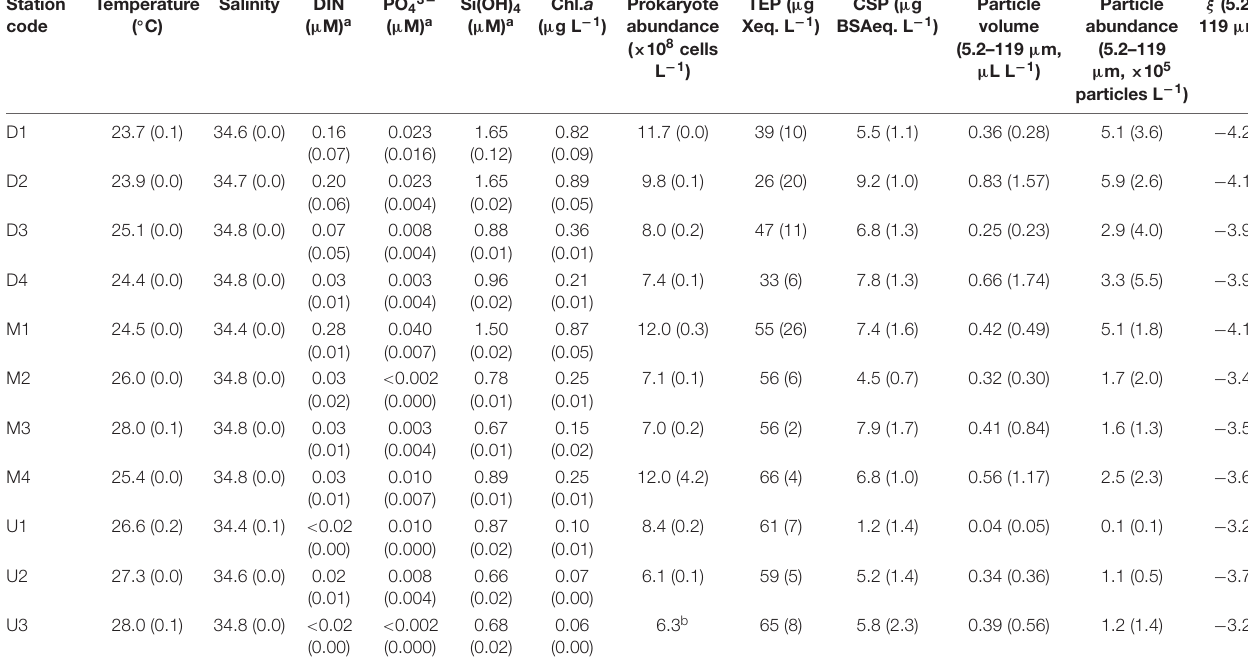
TABLE 2 | Mean values of each variable in the depth of 0–20 m a . Station code